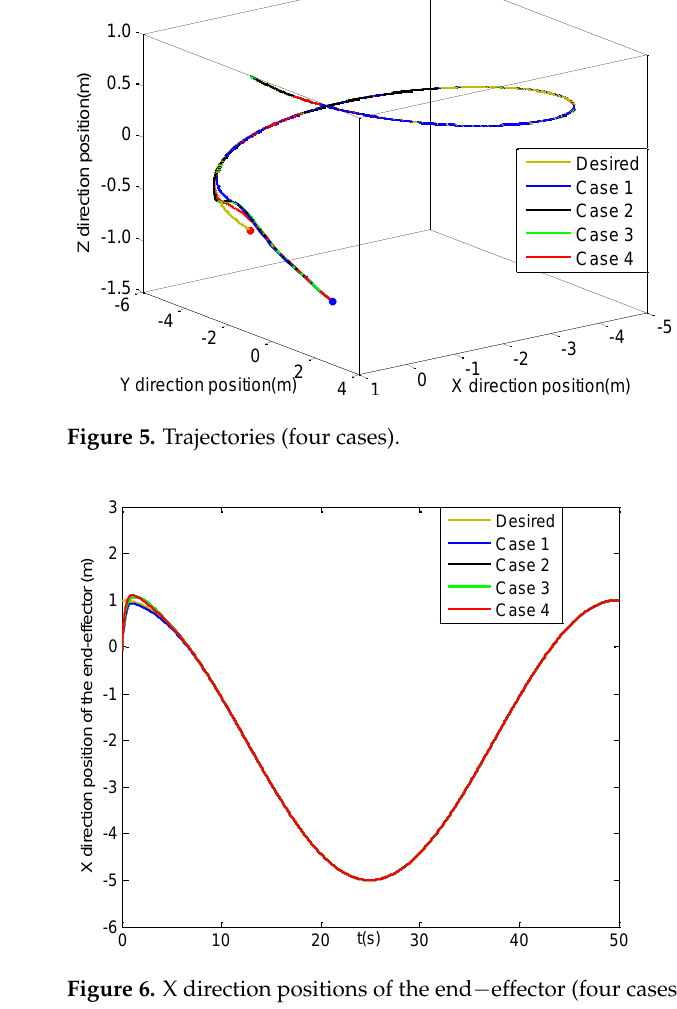
Figure 6. X direction positions of the end − effector (four cases).